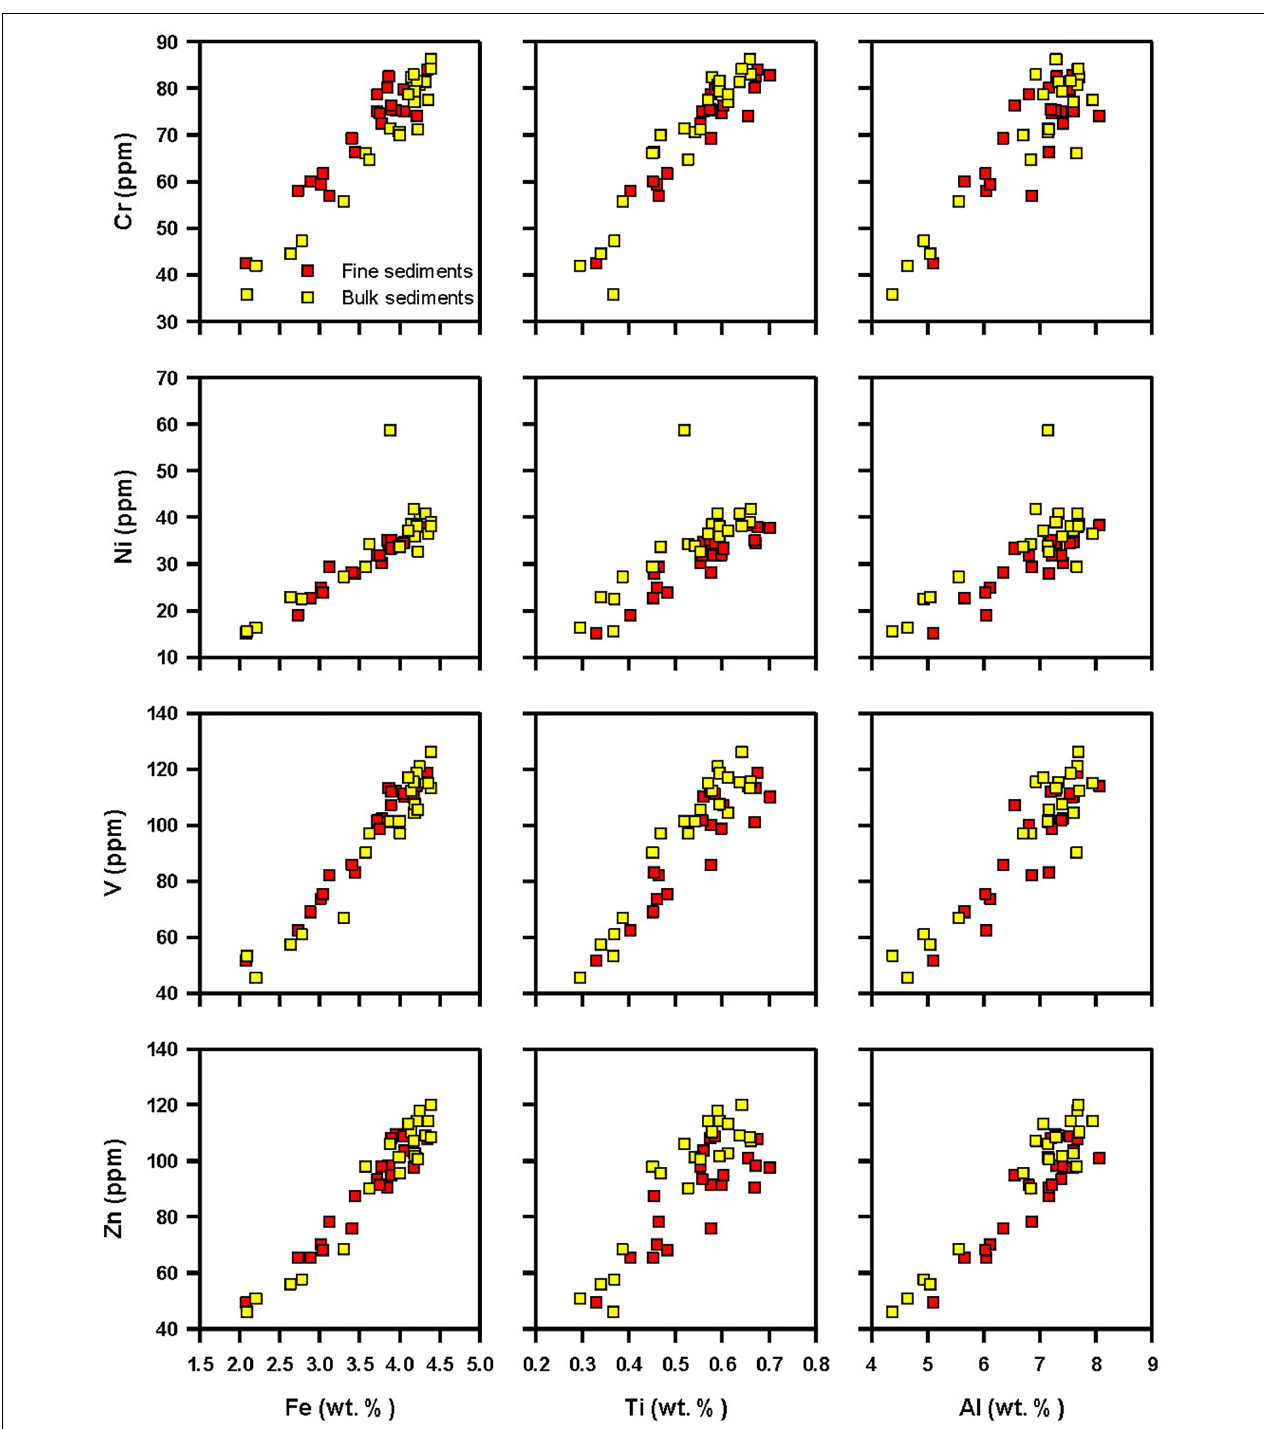
FIGURE 7 | Bi-plots showing linear relationships between major elements (Fe, Ti, and Al) and trace elements (Cr, Ni, V, and Zn) both in fine and bulk factions of surface sediments.